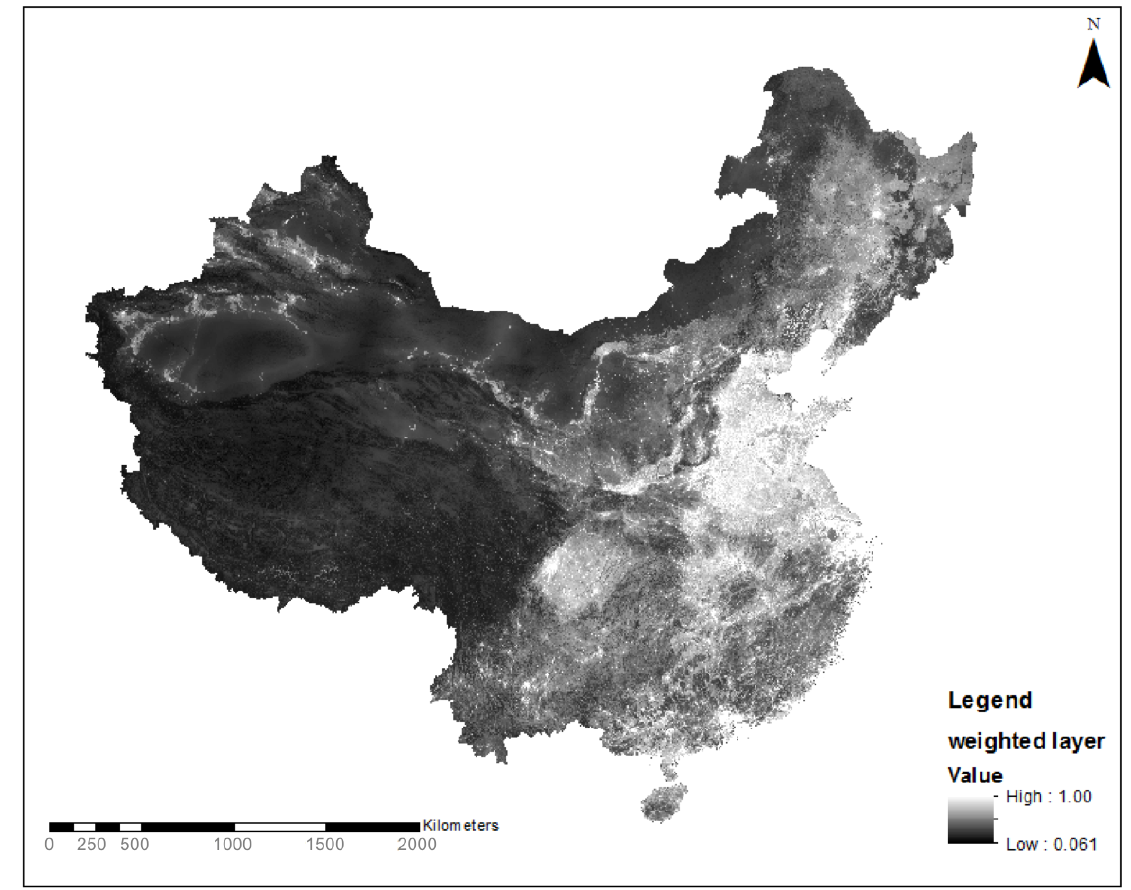
Figure 1. Land suitability